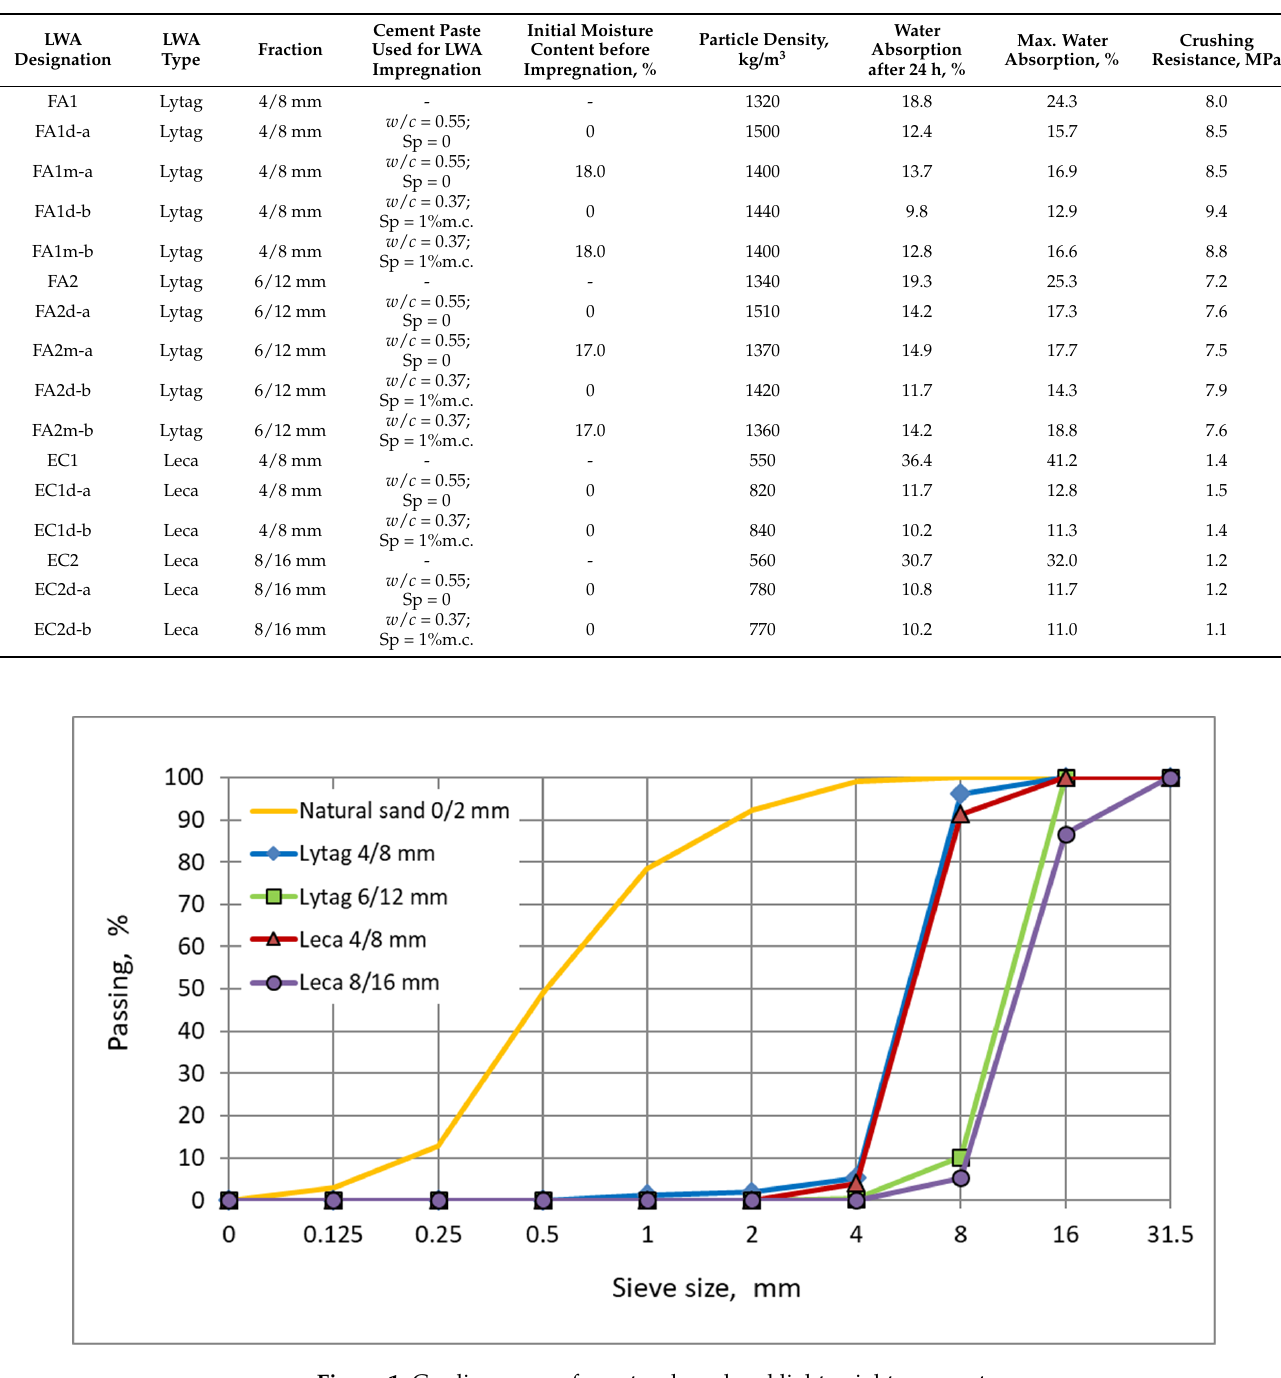
Figure 1. Grading curves for natural sand and lightweight aggregates. To maintain the same consistence, cement paste b with w / c = 0.37 was modified with Table 1. Properties of plain and pre-coated lightweight aggregates used in the research. superplasticizer (Sica Viscocrete). The superplasticizer (Sp) was used in the amount of 1% in relation to cement mass. The thickness of the pre-coated layer on the aggregate shell seemed to be independent on the cement paste type used for impregnation and ranged from 0.1 to 0.3 mm. The examples of various plain and impregnated aggregates used for making concretes are presented in Figure